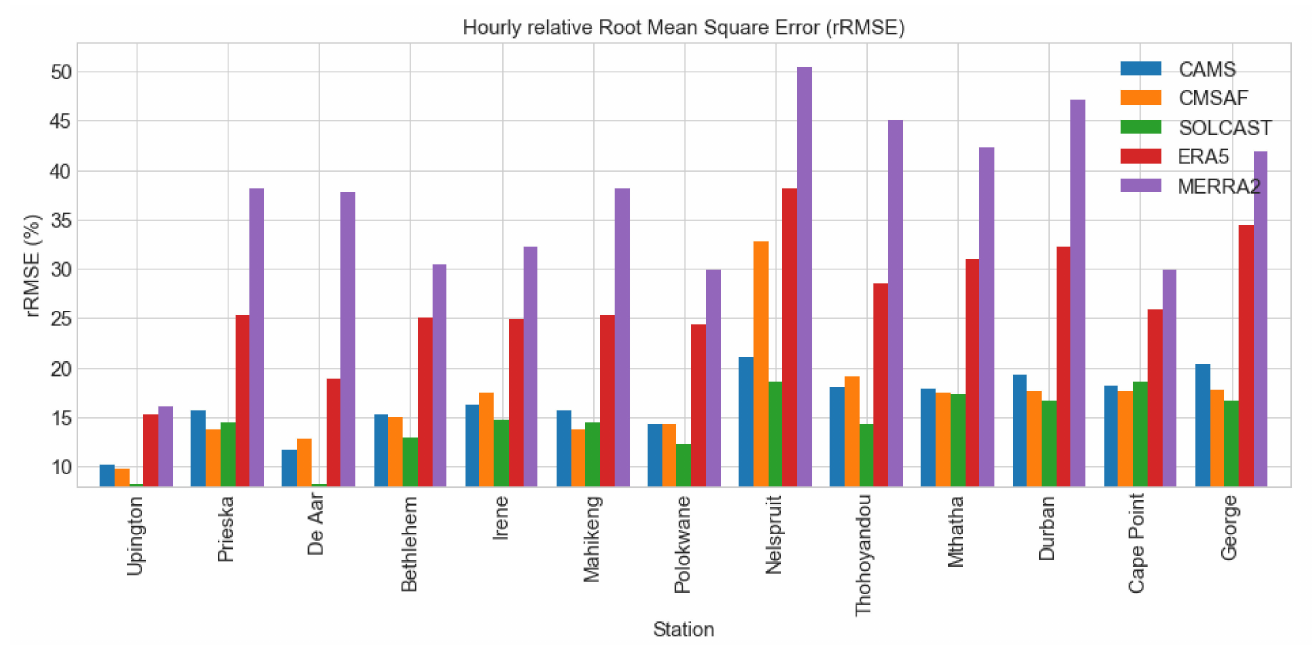
Figure 4. Hourly relative root mean square error of gridded datasets against measured in situ GHI. Table 6. Hourly mean measured GHI (W/m 2 ) and correlation ( R 2 ) of gridded datasets against mea- sured in situ GHI. Green color represents the best ( R 2 > 95), blue color represents the intermediate (90 < R 2 < 95), and orange color represents the poor correlation ( R 2 < 90 ) . Mean GHI Station (W/m 2